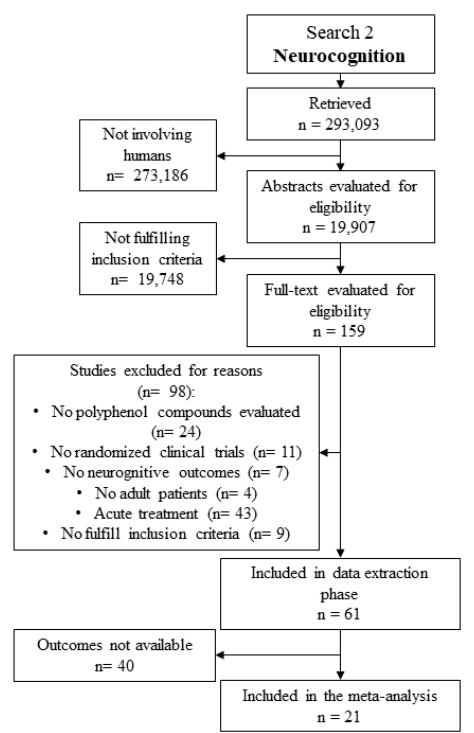
Figure 8. Literature search flow chart for meta-analysis on neurocognitive outcomes.